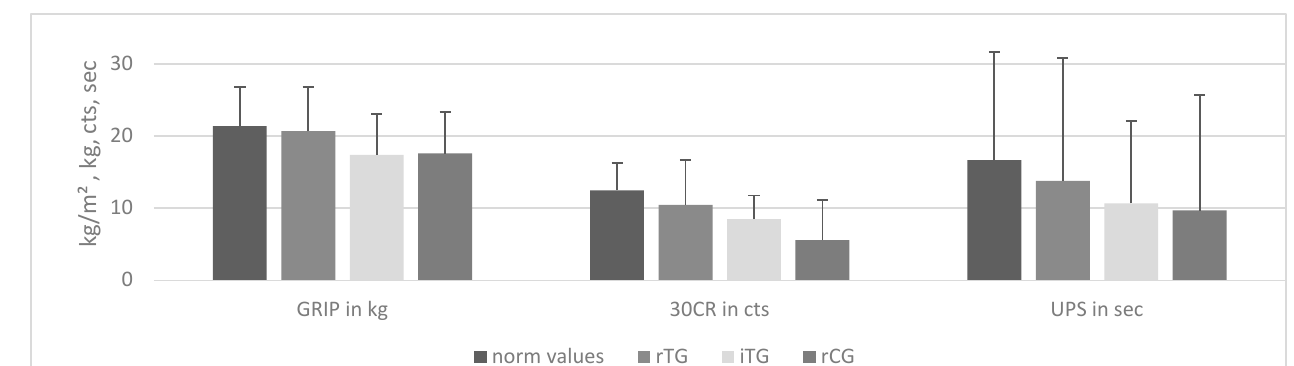
Figure 2. Comparison of Baseline Results With Gender- and Age-Specific Norm Values/This figure shows the baseline data of the subgroups compared to correspondingly matching norm values. GRIP = grip strength; 30CR = 30 s Chair Rise test; UPS = Uni Pedal-Stance. Data presented as mean (incl. SD one-sided) in kg = kilogram, cts = counts or sec = seconds. rTG = regular users; iTG = irregular users; rCG = randomized controls.